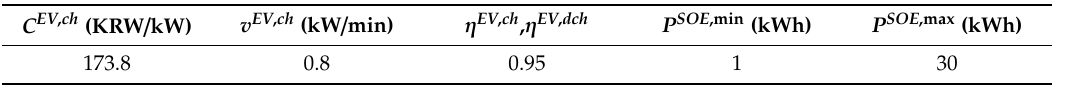
Table A3. EV data.